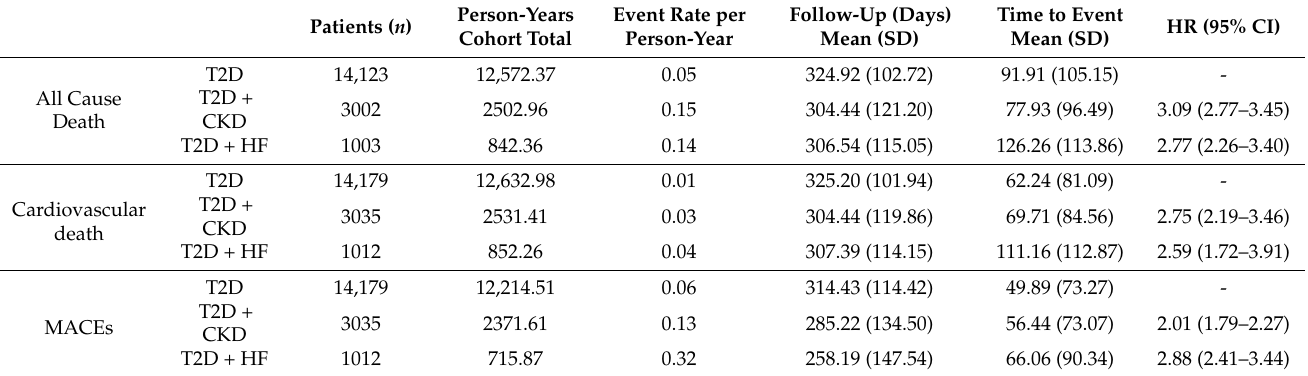
Table 2. Weighted means of hazard ratios (HRs) for all-cause-death, cardiovascular death, and major adverse cardiovascular events